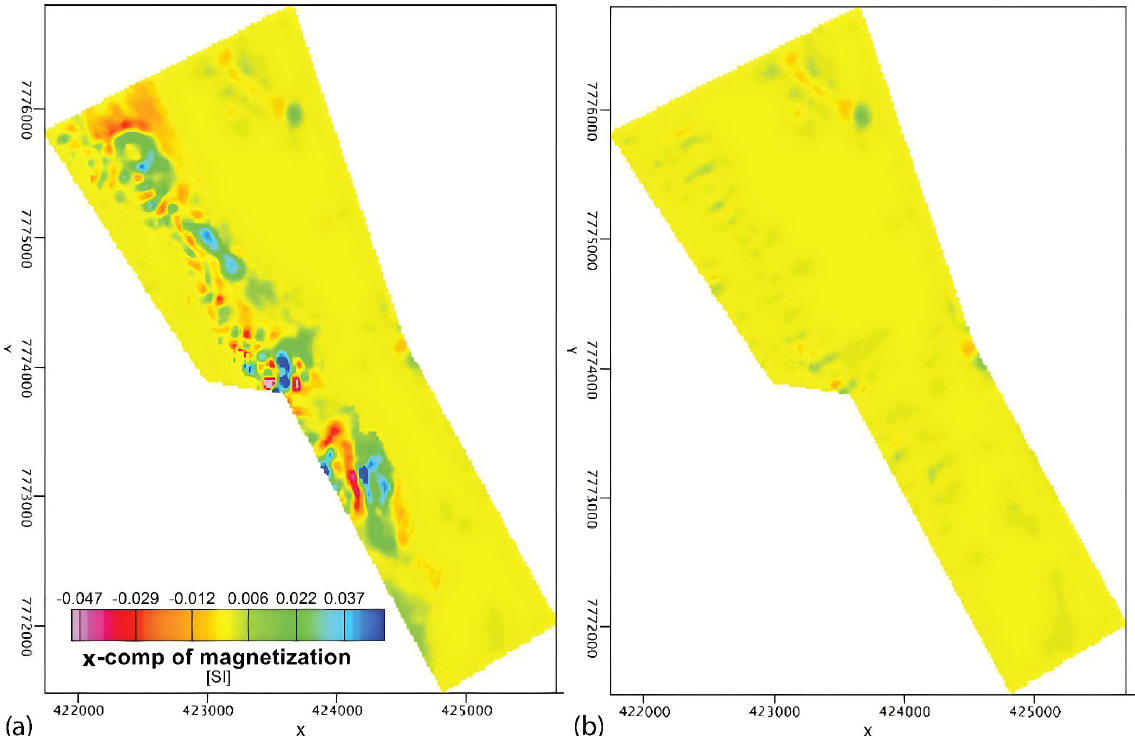
Figure C2. X components of the magnetization 50m below the surface are shown for the two constrained inversion tests. In (a) cells associated with sediment units were constrained towards a non-magnetic reference model (see Figs. 6 and 7), but in (b) in addition the direction of the magnetization in the magmatic units is constrained towards the direction of the regional magnetic field (see Fig. C1).